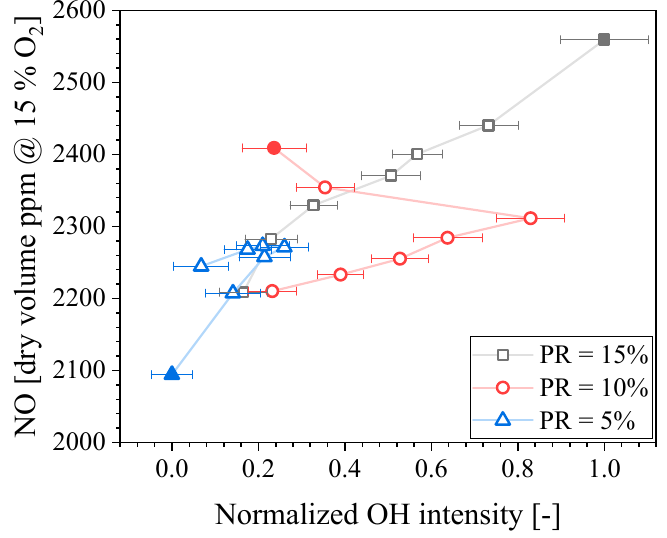
Figure 11 . NO concentration in the exhaust gases as a function of the normalized OH intensity.